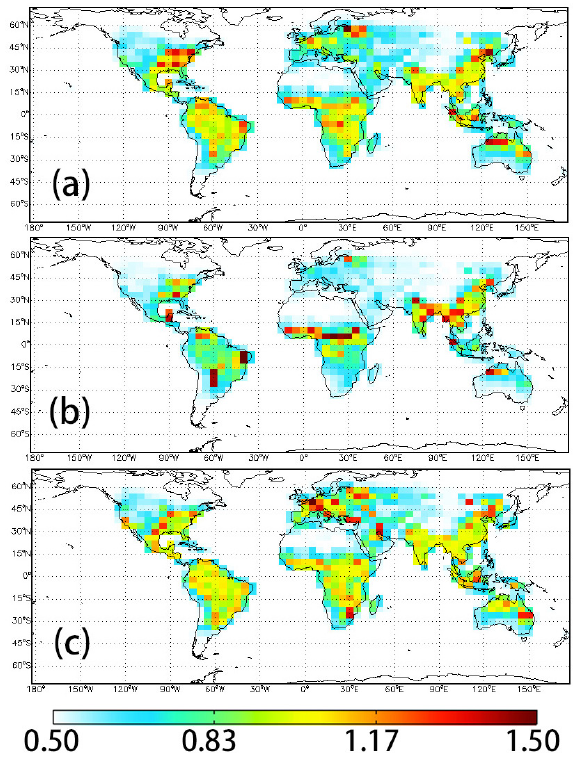
Figure B1. OSSE (Observing System Simulation Experiments) scaling factors for April 2006. The scaling factors represent the ra- tio of the estimated to true emissions. The ratio for the first guess is 0.5. The actual value is 1.0. Shown are the scaling factors obtained with (a) the linear scaling factor optimization, (b) the LOG scaling factor optimization, (c) the LOGX2 scaling factor